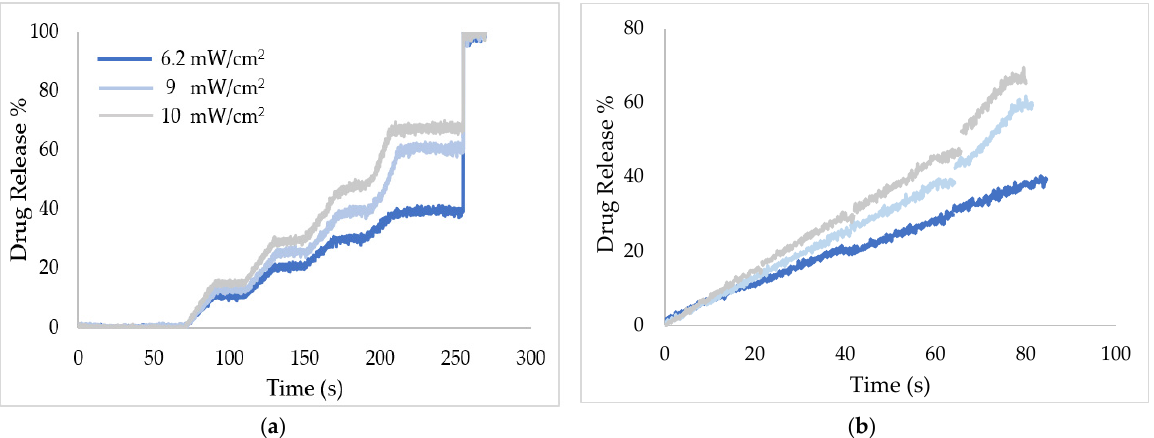
Figure 5. LFUS release profiles for the cRGD-conjugated liposomes. ( a ) Stepped and ( b ) de-stepped data.